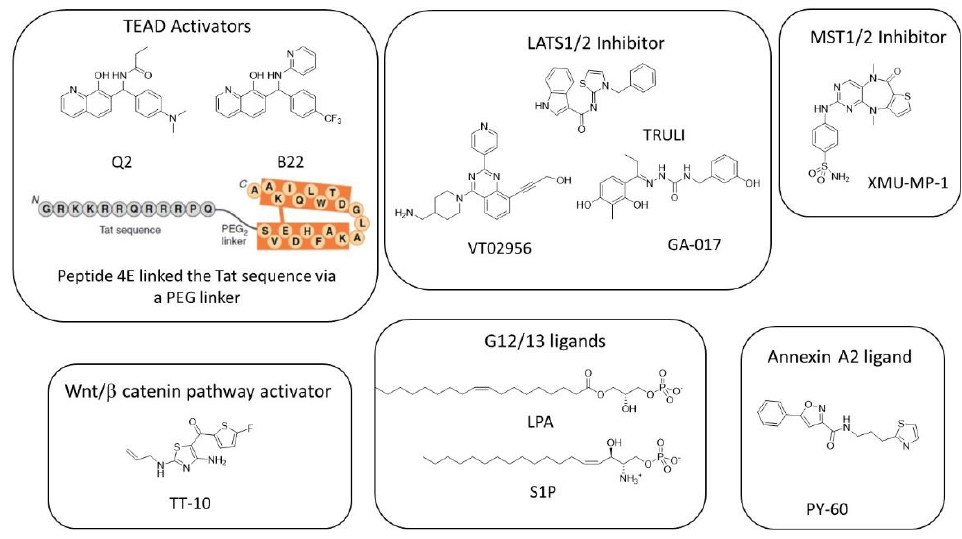
Figure 4. Structure of the known activators of YAP/TAZ – TEAD transcriptional activity.